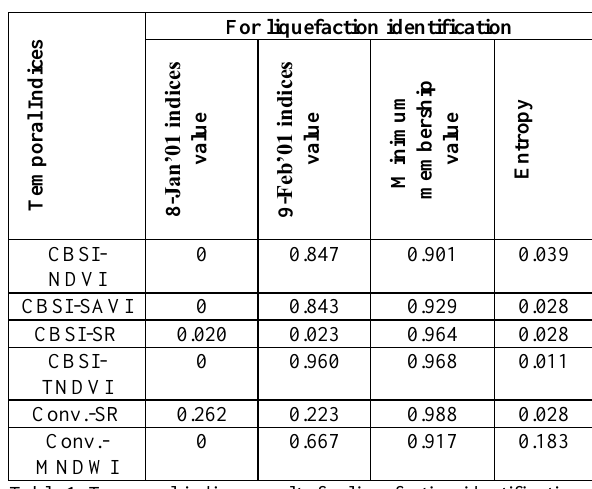
Table 1. Temporal indices results for liquefaction identification